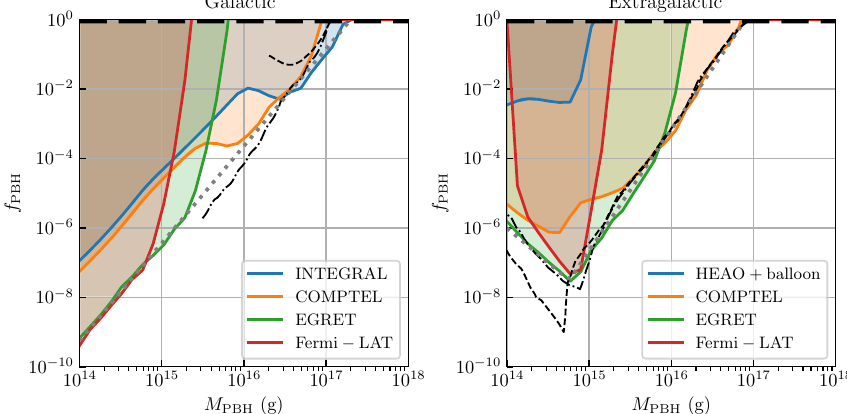
Fig. 2 Left: GC photon flux measured by INTEGRAL [64] ( l ∈ [− 30 , + 30 ] , b ∈ [− 15 , + 15 ] ), COMPTEL [64,65] ( l ∈ [− 30 , + 30 ] , b ∈ [− 15 , + 15 ] ), EGRET [66,67] ( l ∈ [− 30 , + 30 ] , b ∈ [− 5 , + 5 ] ) and Fermi-LAT [68] ( l ∈ [− 30 , + 30 ] , b ∈ [− 10 , + 10 ] ). For complete- ness, we show the following background models: [69] (dashed), [70] (dot-dashed) and [17] (dotted). Right: isotropic extragalactic photon